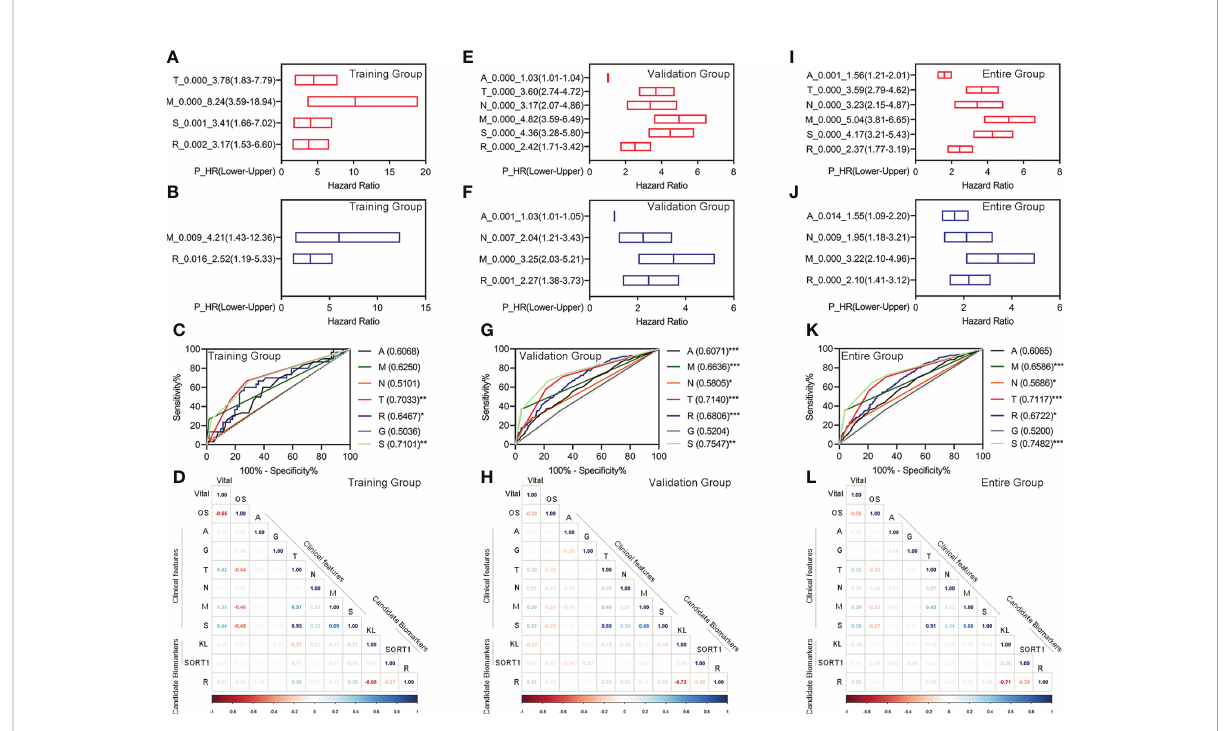
FIGURE 4 Evaluation of the feasibility of the prognostic model and different clinical characteristics. (A – D) Univariate Cox regression analyses (A) , Multivariate Cox regression analyses (B) , ROC curve (C) , and correlation analyses (D) for the prognostic model in the training group. (E – H) Univariate Cox regression analyses (E) , multivariate Cox regression analyses (F) , ROC curve (G) , and correlation analyses (H) for the prognostic model in the training group. (I – L) Univariate Cox regression analyses (I) , multivariate Cox regression analyses (J) , ROC curve (K) , and correlation analyses (L) for the prognostic model in the training group. *p < 0.05 **p < 0.01, ***p <